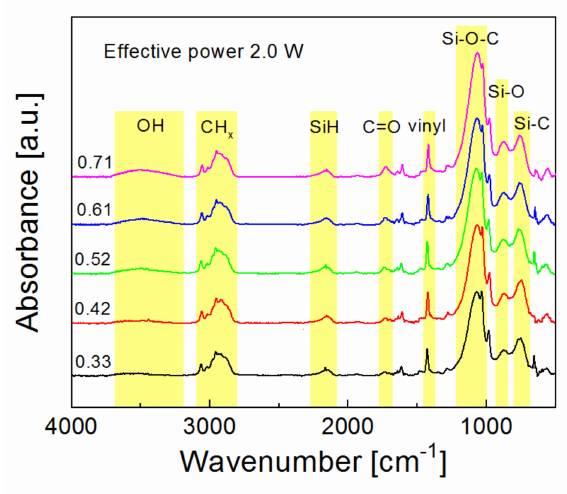
Figure 10. Infrared spectra for plasma nanocoatings deposited at di ff erent oxygen fractions from TVS / O 2